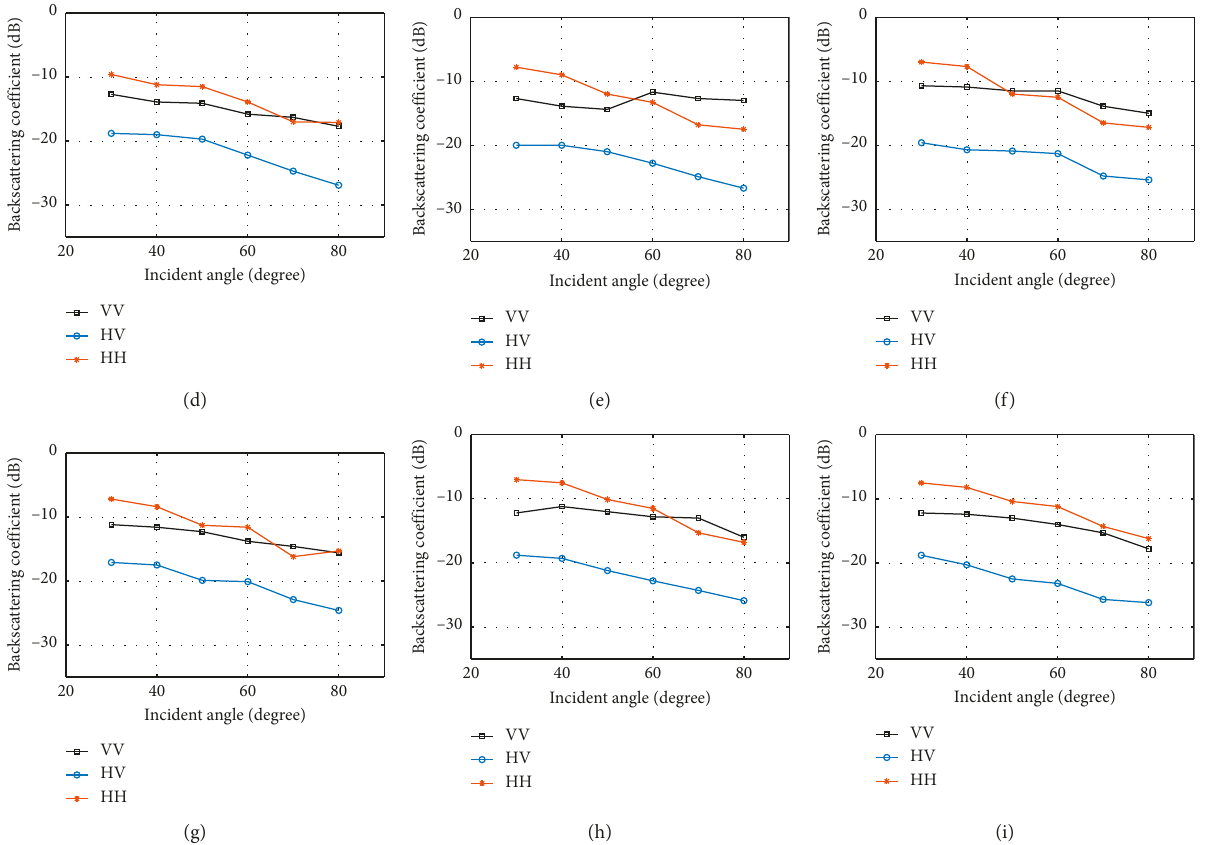
Figure 9: The angular responses of the backscattering coefficient for the banyan tree in (a) 28GHz, (b) 29GHz, (c) 30GHz, (d) 31 GHz, (e) 32GHz, (f) 33GHz, (g) 34GHz, (h) 35GHz, and (i) 36GHz.